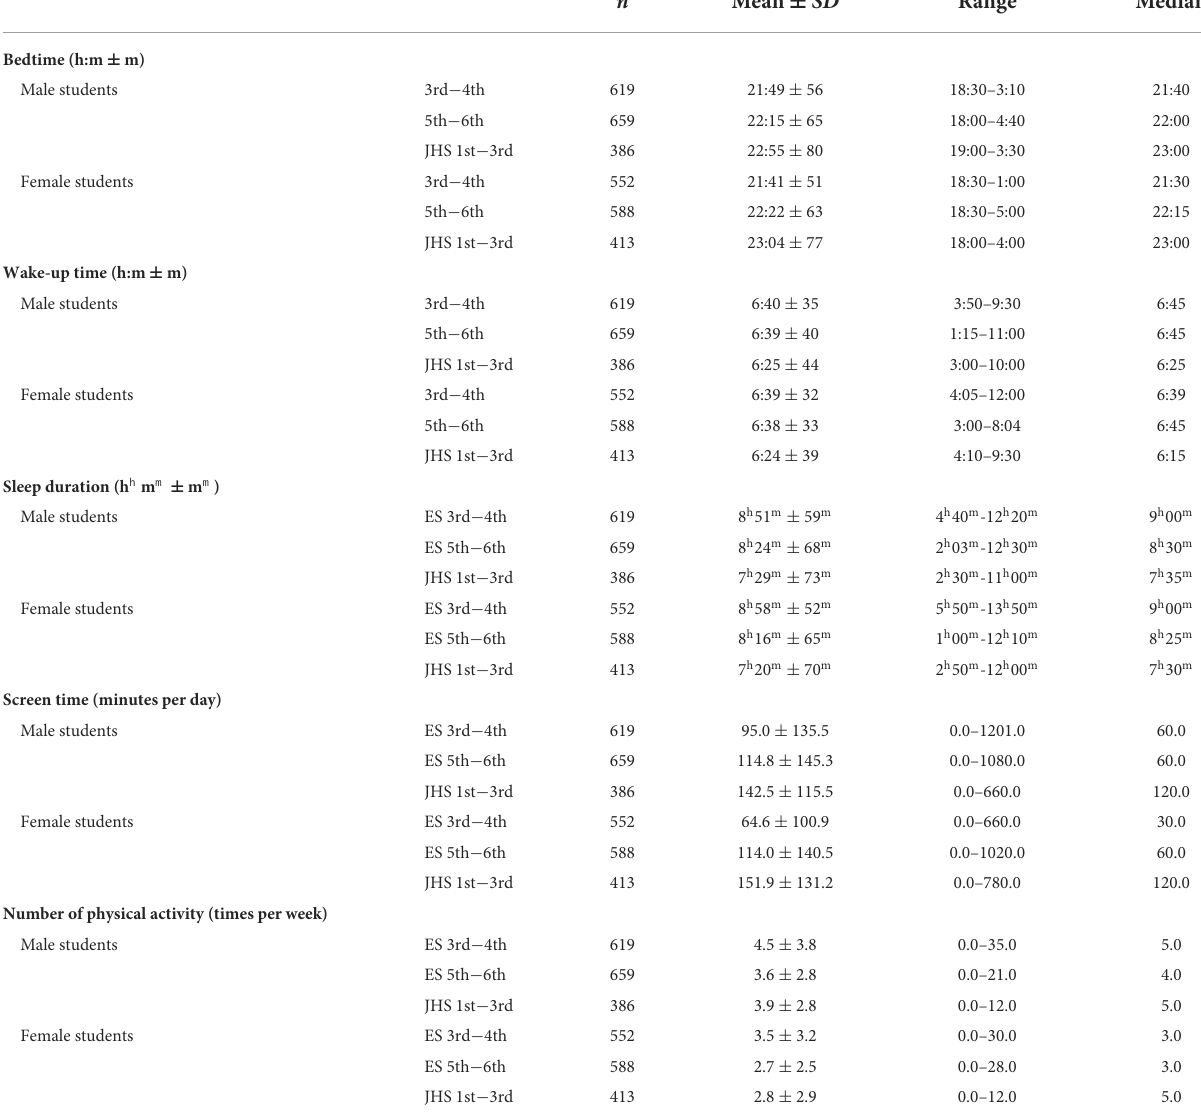
TABLE 1 Participants’ bedtime, wake-up time, sleep duration, screen-time, and physical activity (Per Week). n Mean ± SD Range Median Bedtime(h:m ± m)